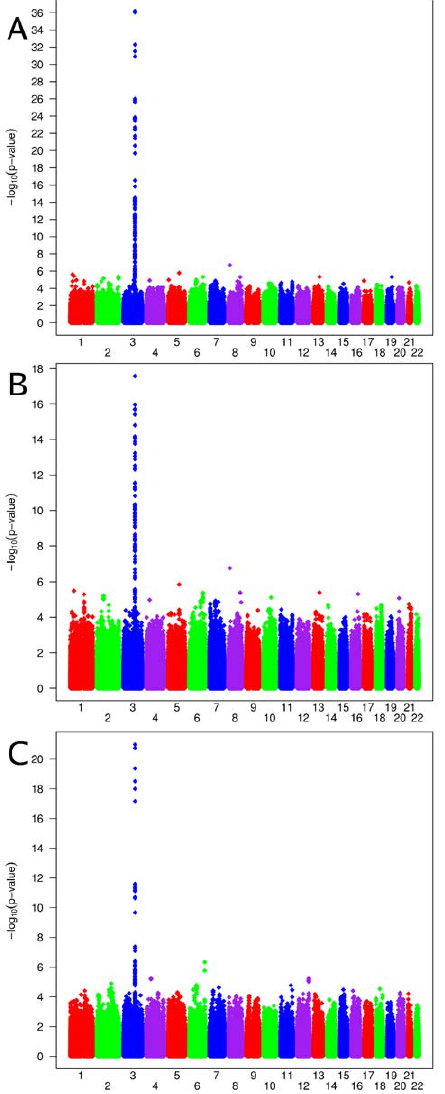
Figure 1. Genome-wide association results. Manhattan plots showing significance of association of all SNPs in the meta-analysis for (A) combined European and Indian Asian cohorts, (B) European cohorts only and (C) Indian Asian cohorts only. SNPs are plotted on the x-axis according to their position on each chromosome against association with serum calcium concentrations on the y-axis (shown as 2 log 10 p- values).